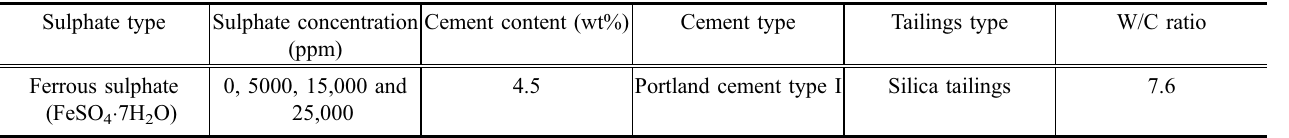
Table 4 Mixture recipe in Case Study